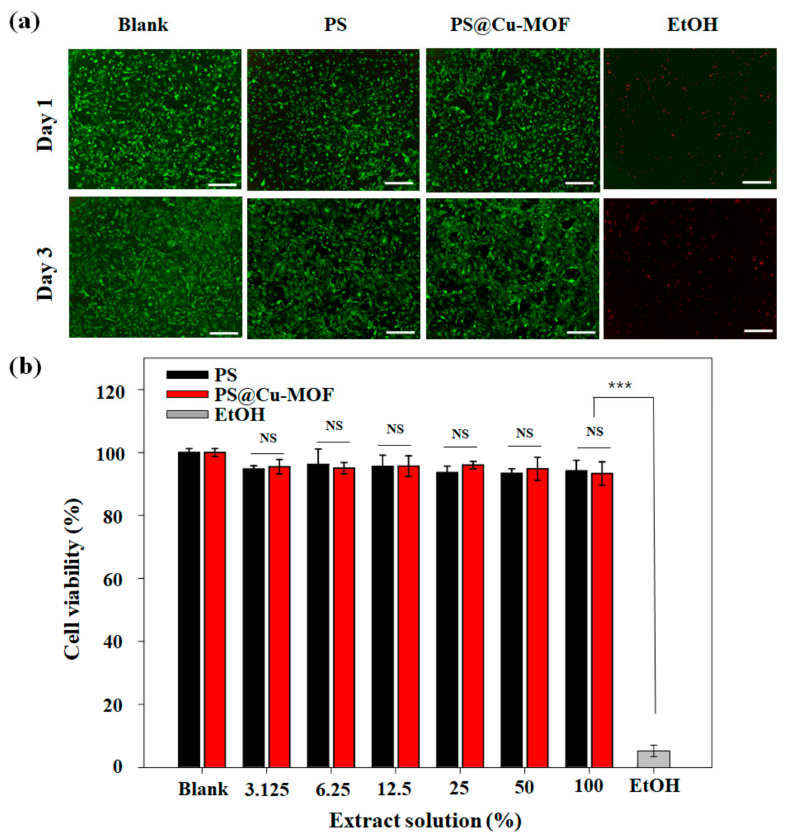
Figure 7. ( a ) Staining images of the live/dead MEFs after contact with PS only or PS@Cu-MOF for 1 or 3 d. Cells cultured without any PS contact were used as a positive control. As a negative control, cells exposed to EtOH were used. ( b ) In vitro cytotoxicity of the extract solution of PS and PS@Cu- MOF to MEFs (n = 4); means ± standard deviation with n = 4; NS: not significant; *** p < 0.001. Scale bar: 200 µ